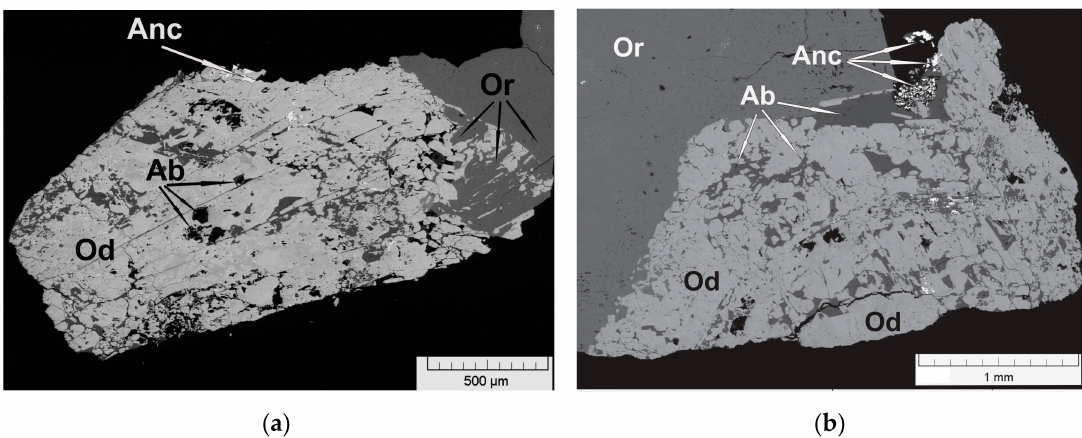
Figure 2. Fragments of odikhinchaite (Od) individuals with albite (Ab) inclusions in association with ancylite-(Ce) (Anc) and orthoclase (Or). BSE images of polished